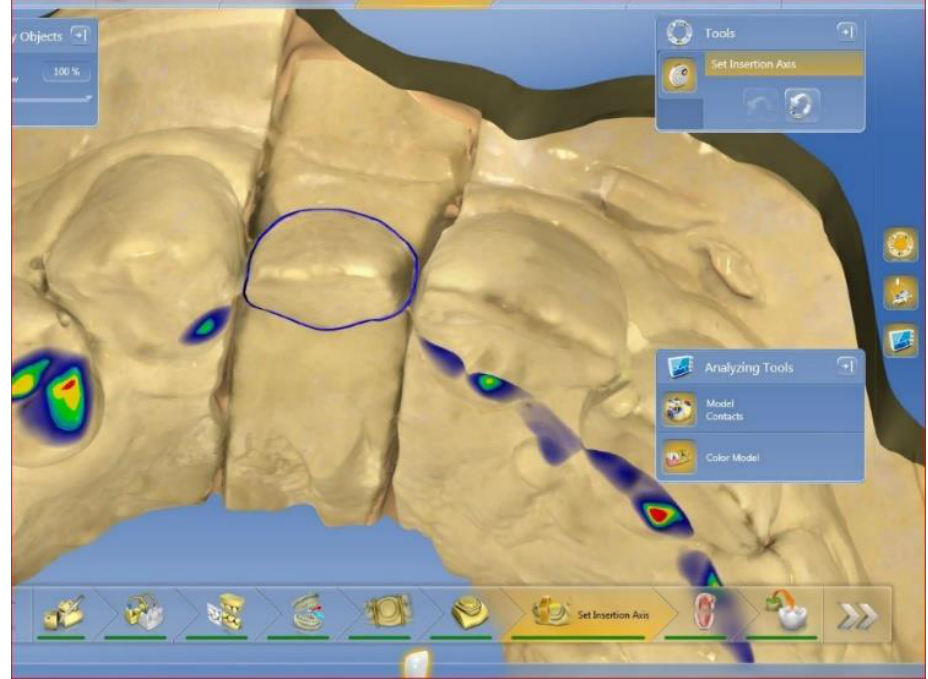
Figure 2. Digital planning of the restoration.